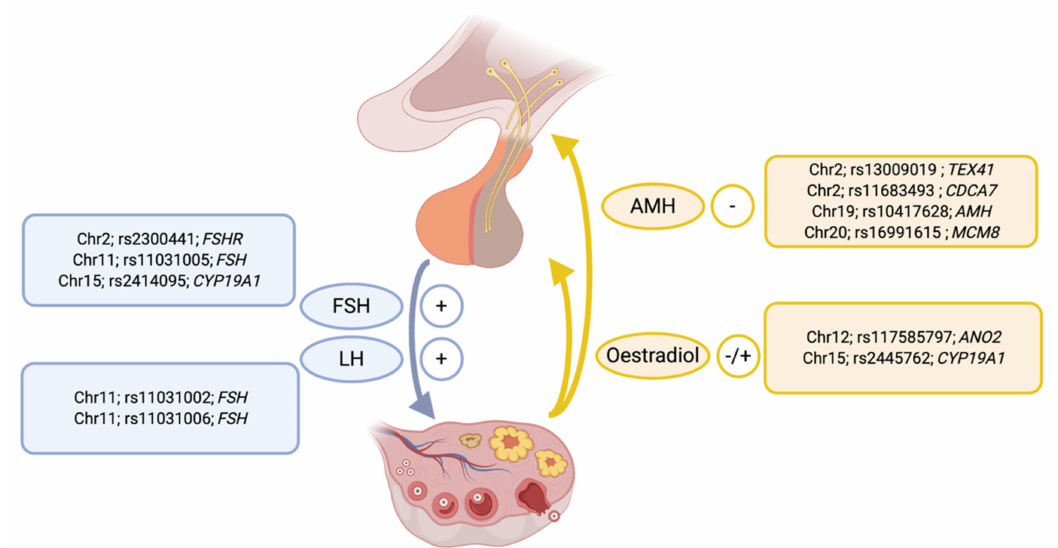
Figure 1. The location and lead SNP for genetic variants significantly associated with the measured concentrations of key hormones involved in hypothalamic-pituitary regulation of ovarian function. The nearest gene to the lead SNP for each genetic signal is also